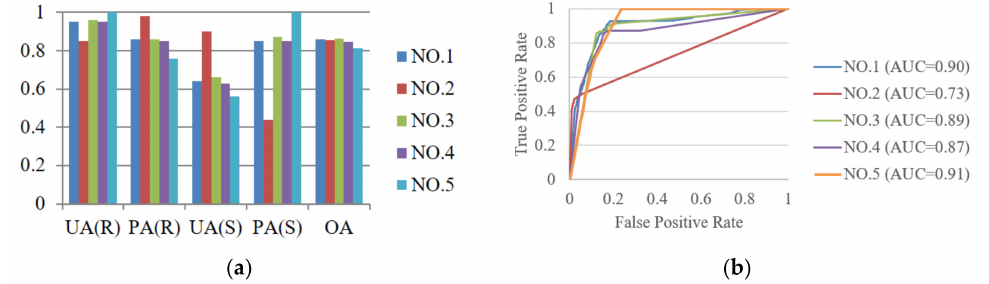
Figure 13. Comparison of the representative results using the RF method for the No. 2, 3, and 4 models, with costs of 5000 and 2000 for No. 1 and 5 models, respectively. ( a ) User’s accuracy (UA), producer’s accuracy (PA), and overall accuracy (OA); ( b ) area under the ROC curve (AUC) for landslide source (S) and runout (R)